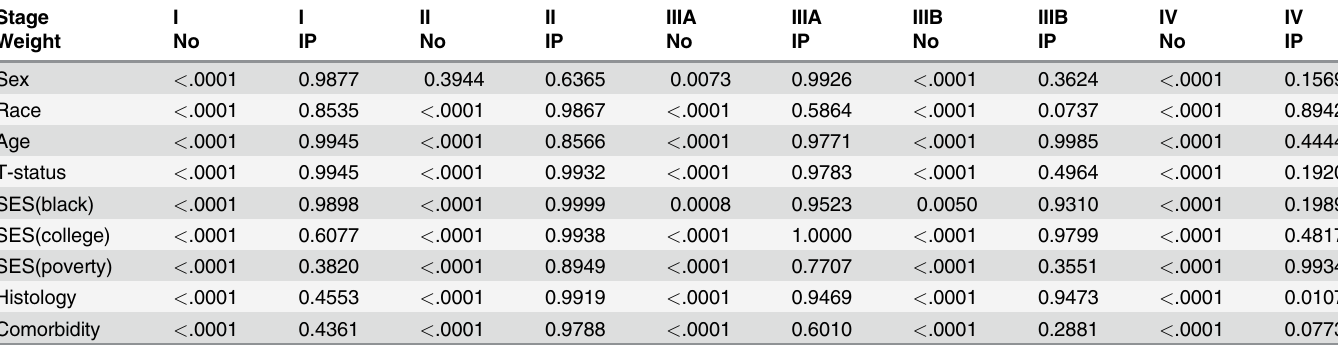
Table 2. The p-values of the χ 2 -tests for treatment-group comparison of stage-specific cohorts of lung cancer patients calculated for original and pseudorandomized (i.e., weighted) populations. Stage